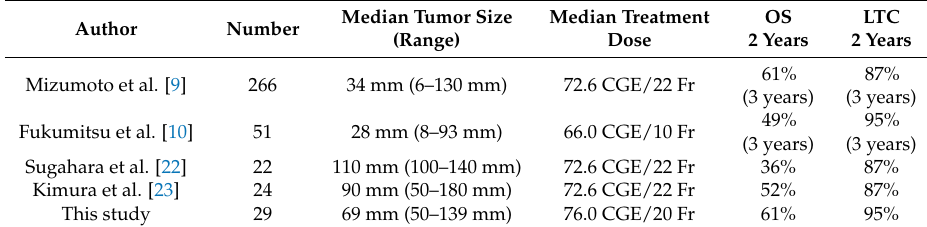
Table 3. Reports of proton beam therapy for